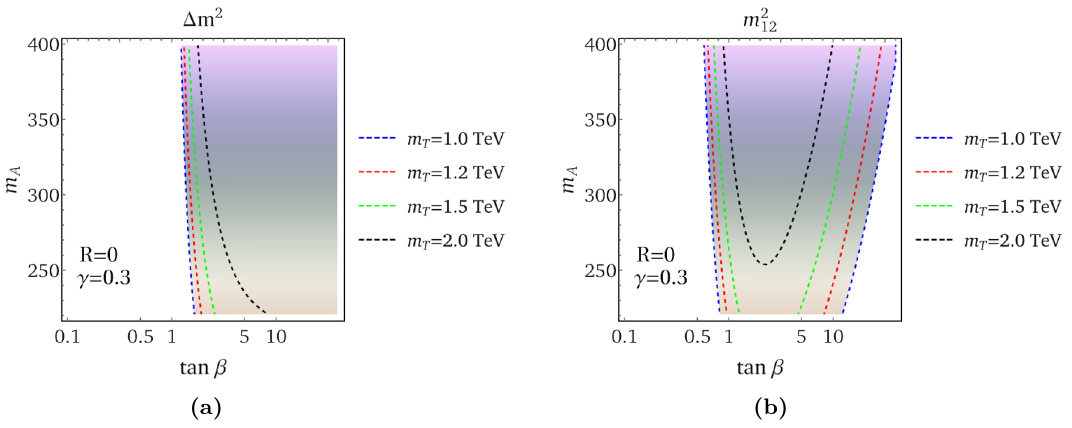
Figure 4. Dependence of the degree of fine-tuning for various masses of the vector-like top quark partner. The shaded region inside and/or above each respective contour corresponds to a fine- tuning of at most 5% . Both panels employ the benchmark points R = 0 and γ = 0 . 3